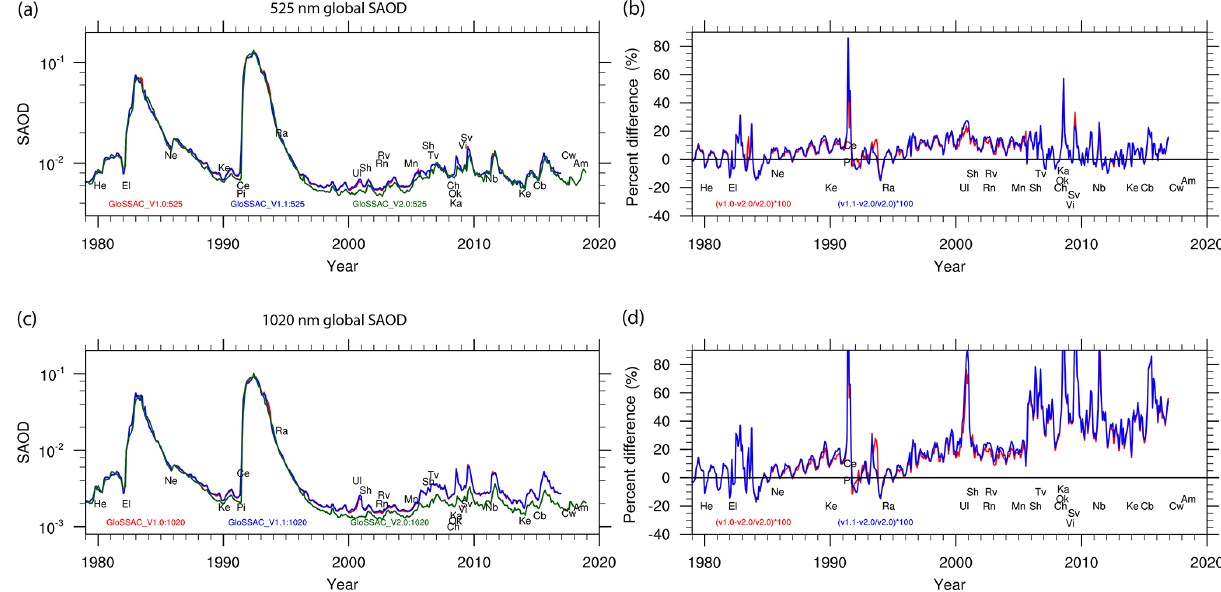
Figure 18. Global stratospheric aerosol optical depth at 525 (a) and 1020nm (c) . Percent difference between versions for 525 and 1020nm extinction are shown in (b) and (c) respectively. Percent difference are computed with respect to v2.0 as (v1.0 (v1.1) − v2.0 / v2.0) ·